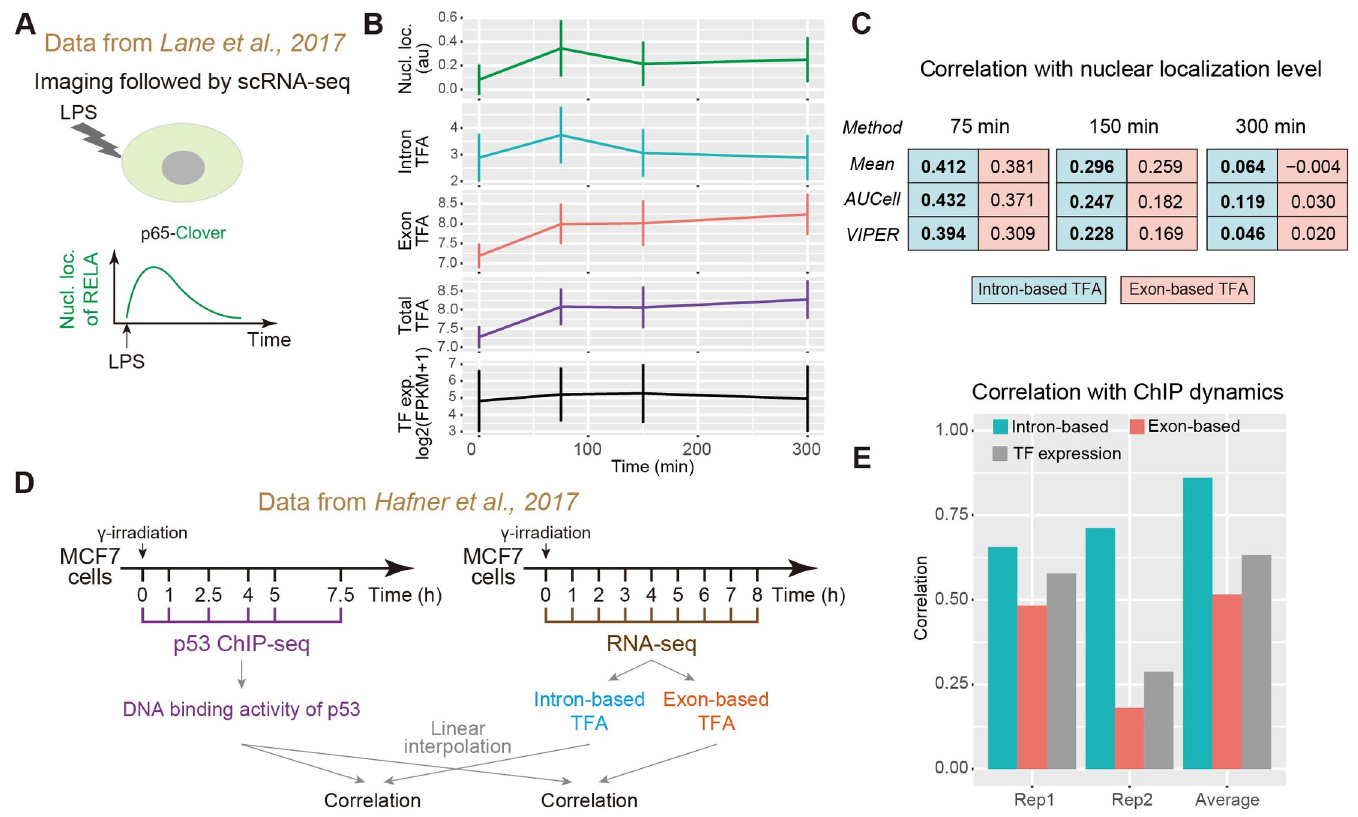
Fig 2. Validation of intron-based TF activity estimation using public multimodal datasets. (A) Schematic of the experimental design of Lane et al [41]. After LPS stimulation, the nuclear localization dynamics of NF- κ B were recorded in single cells, whose transcriptomes were then sequenced at 75 min, 150 min, or 300 min post LPS stimulation. (B) Characterizations of NF- κ B activity dynamics using NF- κ B nuclear localization level, intron-based NF- κ B activity, exon-based NF- κ B activity, total reads-based (i.e., intron plus exon) NF- κ B activity and NF- κ B expression level. Error bars represent standard deviations. Data were taken or reanalyzed from Lane et al [41]. n = 186, 145, 383, and 124 cells from left to right. (C) Correlations between single-cell NF- κ B nuclear localization level and intron- or exon-based TFA at three time points. For each time point, TFA was calculated by mean expression (as in Fig 1D ), AUCell [22] or VIPER [23] (see Materials and Methods). (D) Schematic of the experimental design of Hafner et al [39] and the steps involved in our analysis. After stimulation by irradiation, bulk p53 ChIP-seq and RNA-seq were performed in different time points. To compute correlation, time series data were linearly interpolated. (E) Correlations between p53 DNA binding dynamics computed from ChIP-seq data and intron-based TFA, exon-based TFA, or p53 expression level. ‘Rep1’ and ‘Rep2’ represent using data from two separate RNA-seq replicates, and ‘Average’ represents using the mean of the two replicates.